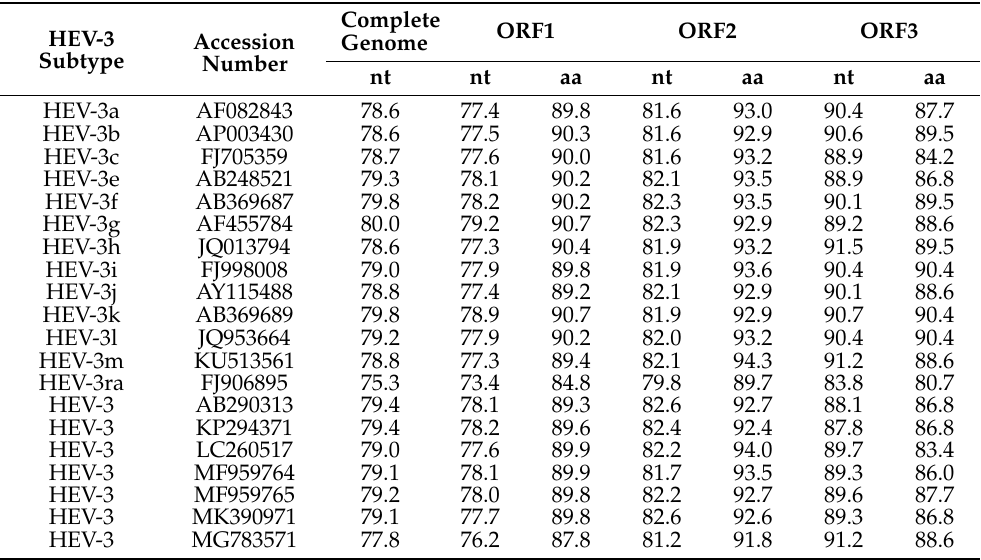
Table 1. Nucleotide (nt) and amino acid (aa) sequence identities (in %) between novel strain rab81